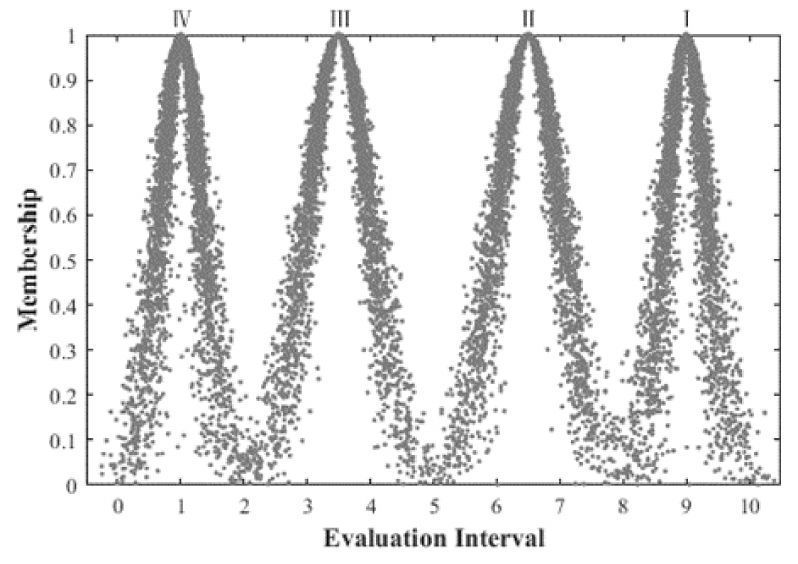
Figure 3. Cloud criterion of comment